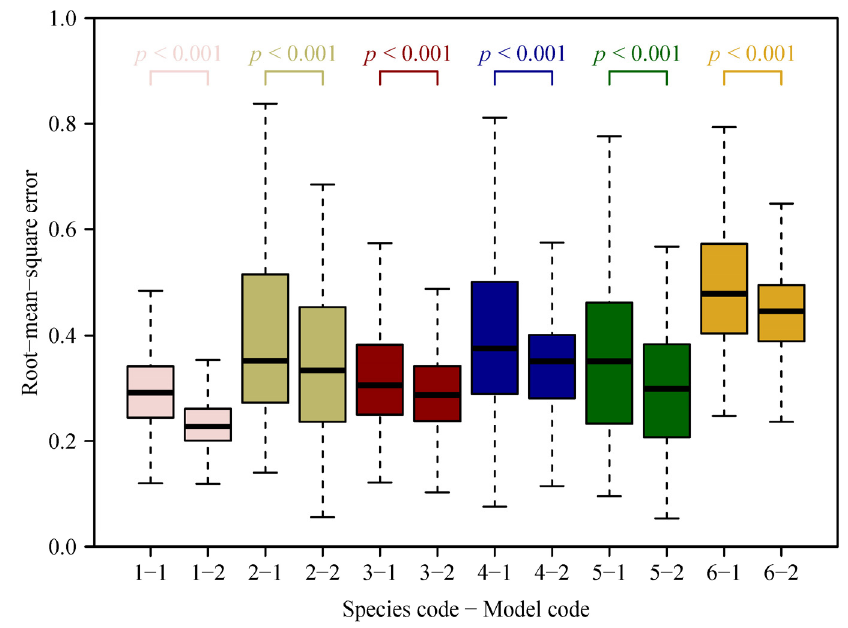
Figure 4. Comparison of the root–mean–square errors (RMSEs) between the two simplified Gielis models (SGE-1 and SGE-2, i.e., Equations (3) and (4)) for the studied six Pleioblastus species (Table 1 for species codes). The thick horizontal lines within the boxes represent median values of RMSEs; the box length represents the difference between the 3rd/4th quantile and the 1st/4th quantile; whiskers give 1.5 times the box length or maximum (or minimum) values. The two groups of RMSEs between the two models (1 and 2) for each species (1 to 6) were compared by a paired sample t -test.